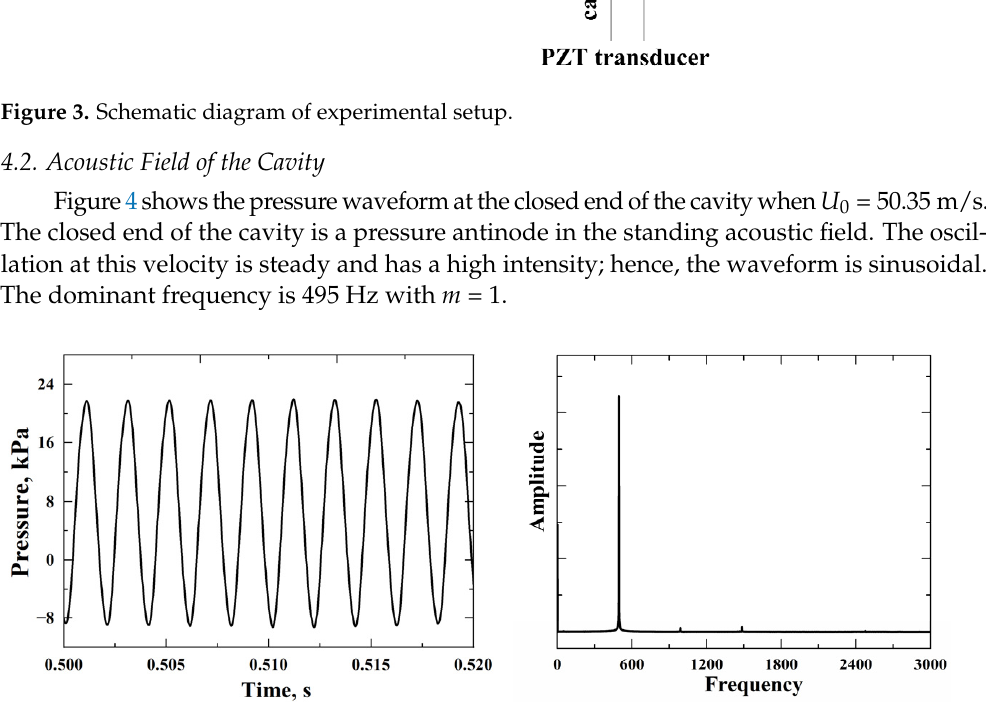
Figure 4. Pressure waveform and spectrum analysis.